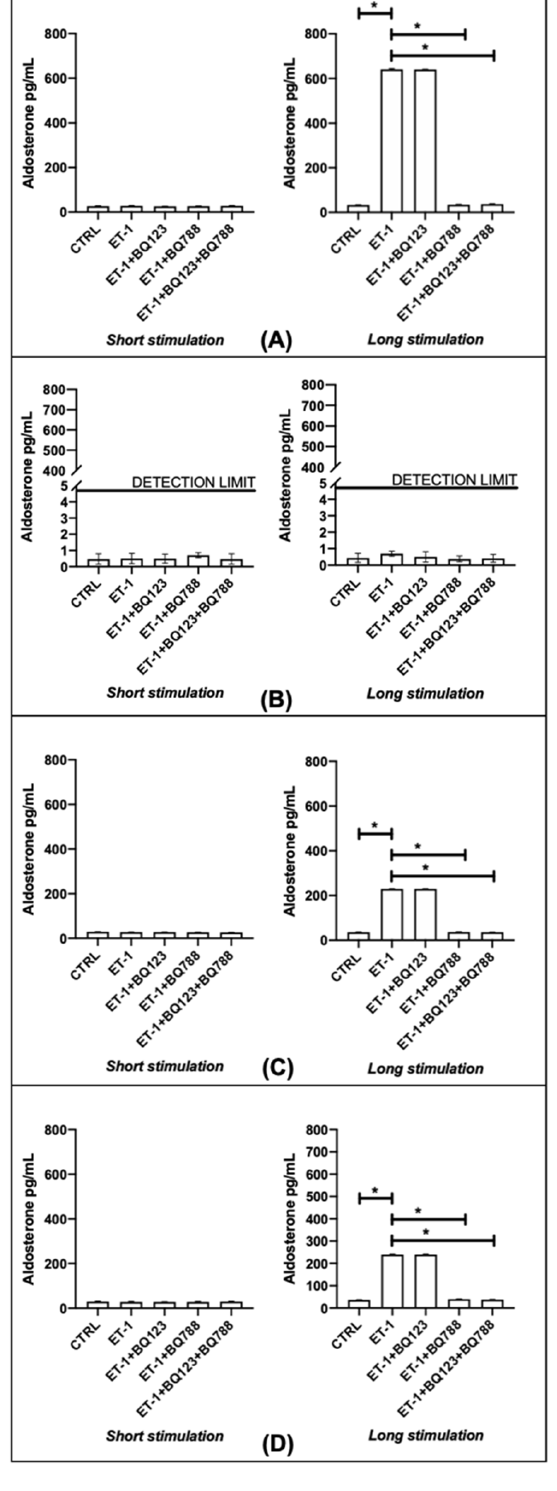
Figure 7. Aldosterone production in ( A ) HPFs, ( B ) HDFs, ( C ) lSScHDFs, and ( D ) dSScHDFs. All cells analyzed except HDFs produce aldosterone reported in pg/mL after long ET-1 stimulation of 24 h, and the antagonism of ETB (BQ788) inhibits this effect. (* p < 0.05). (HPFs: human pulmonary fibroblasts; HDFs: human dermal fibroblasts; lSScHDFs: limited scleroderma dermal fibroblasts; dSScHDFs: diffuse scleroderma dermal fibroblasts; ET-1: endothelin-1; BQ123: ETA blocker; BQ788: ETB